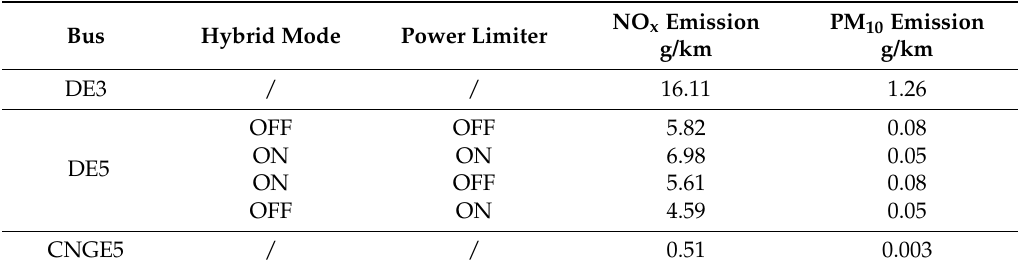
Table 4. Average NO x and PM 10 specific mass emissions for observed